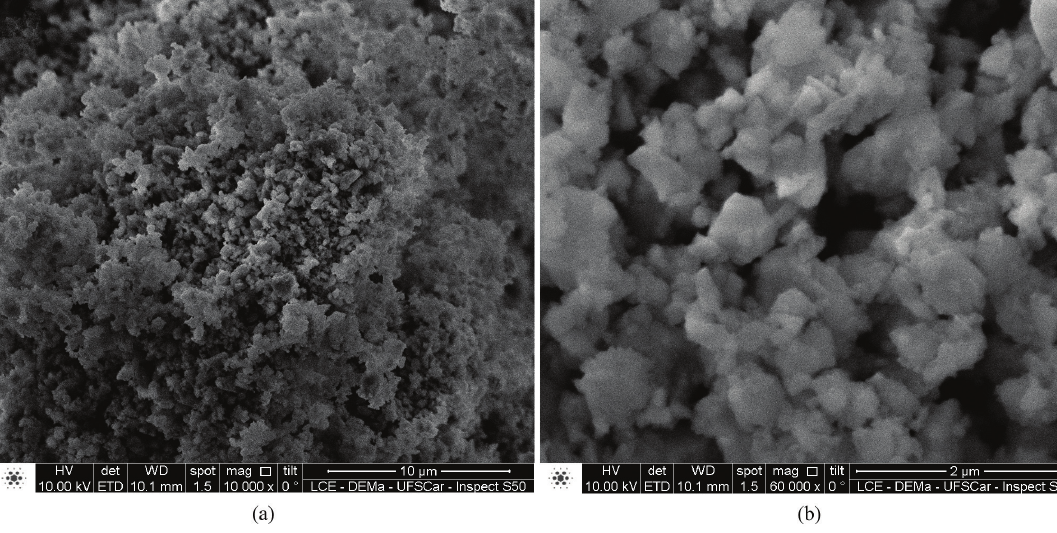
Figure 2. SEM micrographs of BSCF powder in two different magnifications: 10000X (a) and 60000X